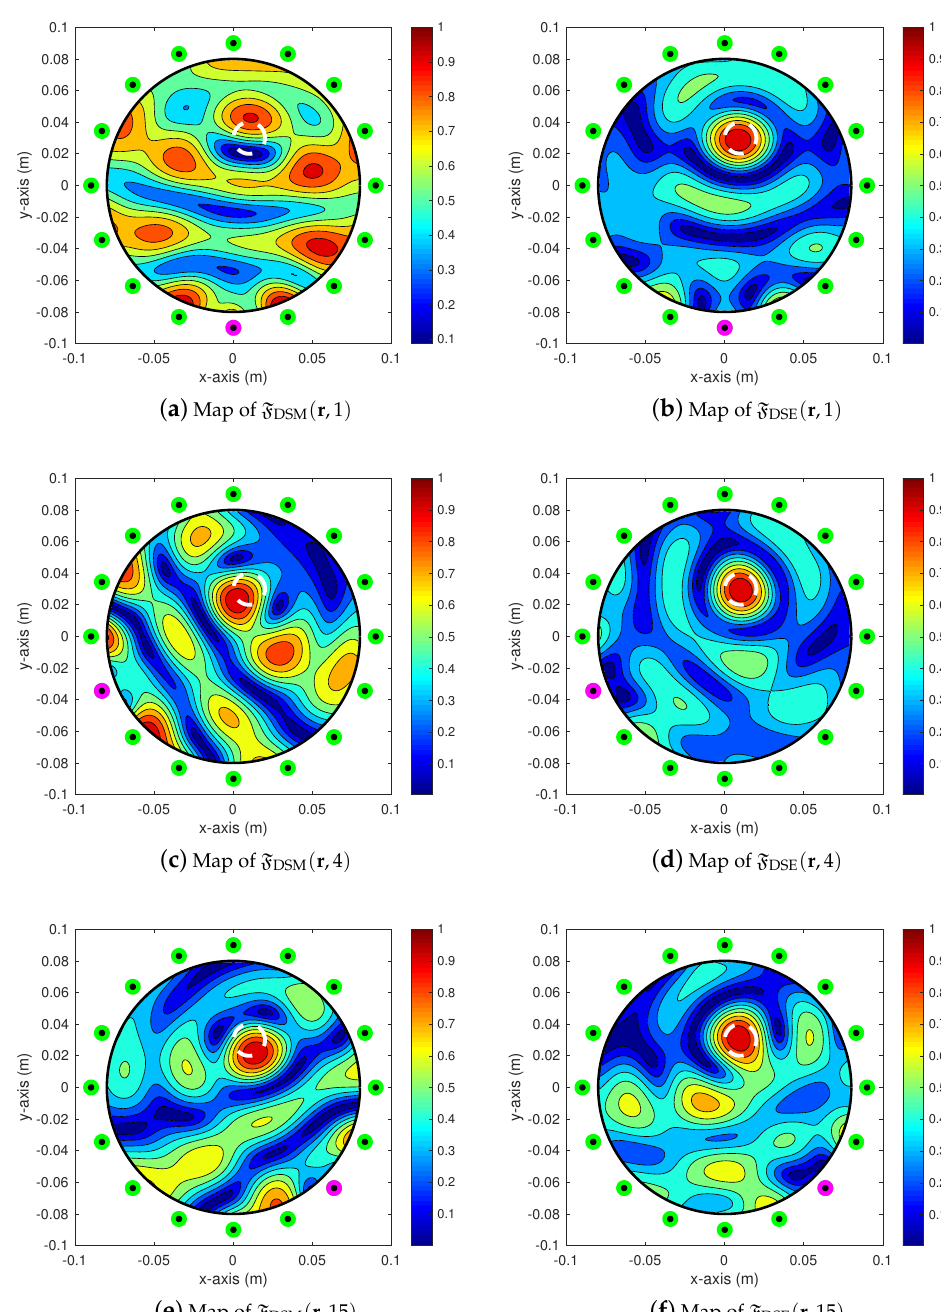
Figure 2. Maps of F DSM ( r , m ) and F DSE ( r , m ) at f = 0.925GHz. White-colored dashed line describes the ∂ D